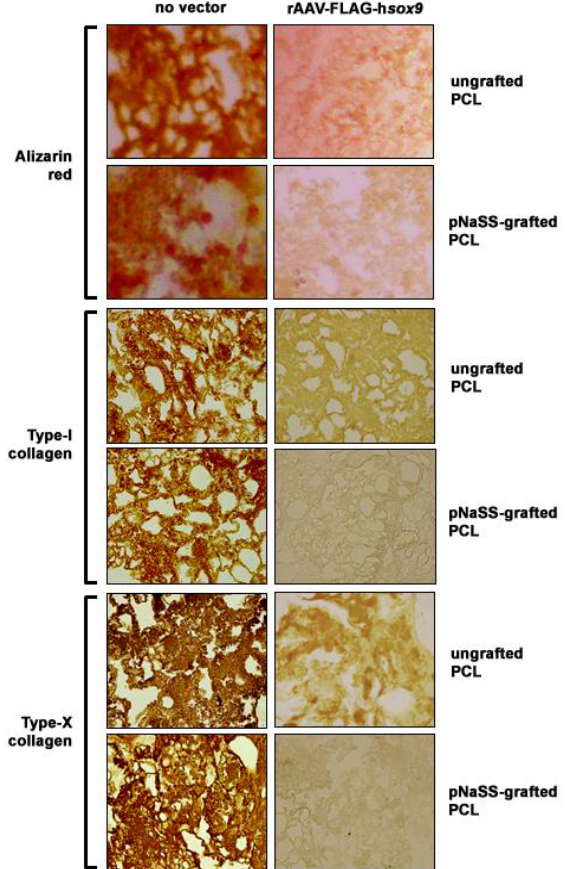
Figure 3. Reduction of mineralization and type-I and -X collagen deposition in human bone marrow aspirates transduced with rAAV sox9 -coated PCL films. pNaSS-grafted and ungrafted PCL films were coated with rAAV-FLAG-h sox9 or let without vector treatment prior to incubation with the aspirates and mineralization (alizarin red) and type-I and -X collagen immunoexpression were evaluated after 21 days (magnification × 20; all representative data).